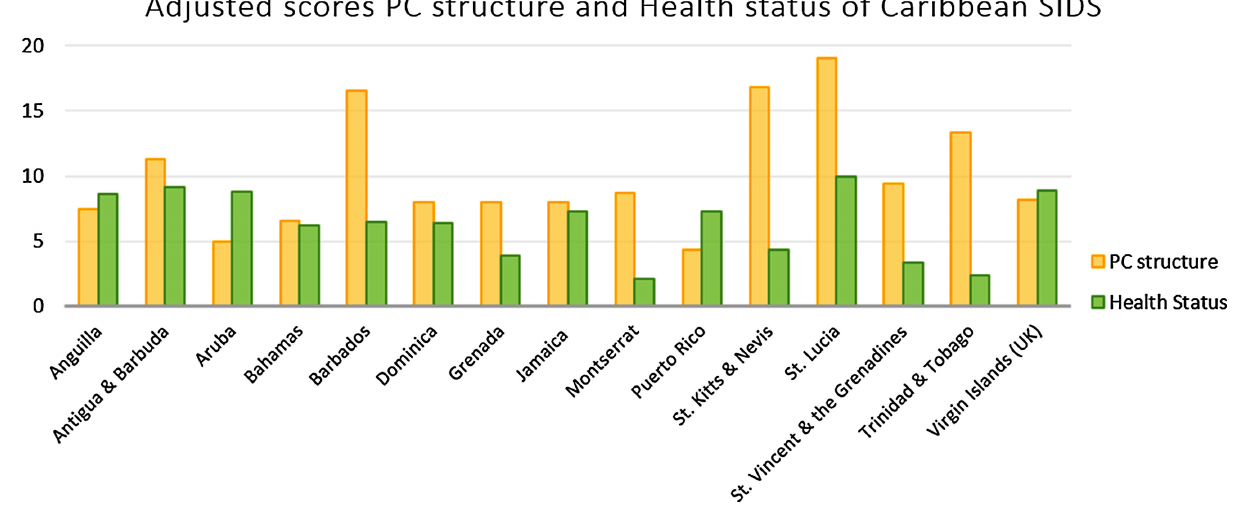
Figure 4 . Scores of health status and PC structure.